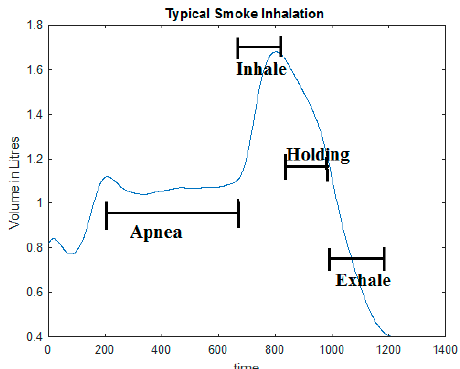
Figure 2. An illustration of a smoking-specific respiration pattern (horizontal axis: Time in milliseconds, vertical axis: Breath volume).